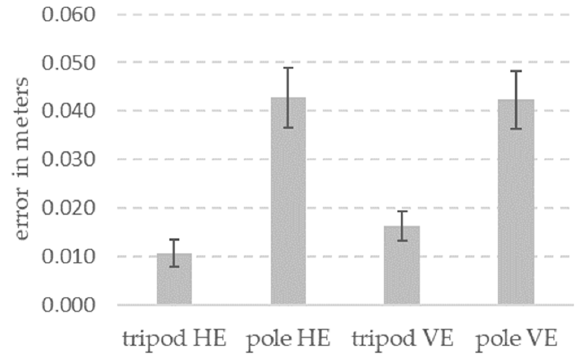
Figure 23. Horizontal error (HE) and vertical error (VE) obtained on the basis of Trimble Geo7x GNSS receiver measurements on geodesic points in tripod and pole mode.